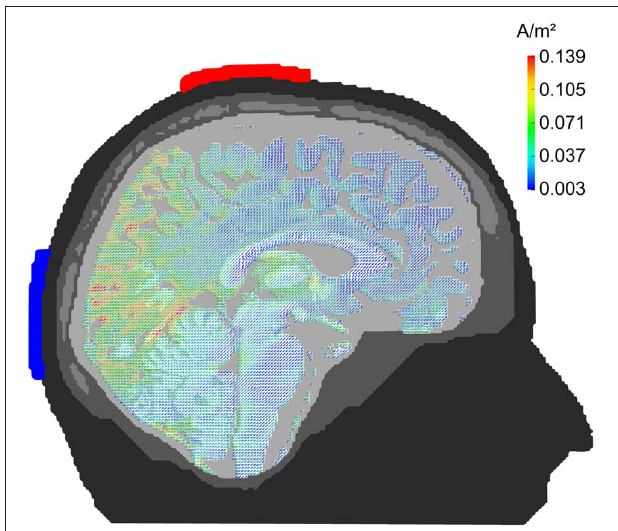
FIGURE 1 | Current density distribution. Results of a finite-element model simulation of tACS (Neuling et al., 2012a). Simulation electrodes are centered at electrode positions Cz and Oz of the 10/20 system. Current densities are highest in the posterior